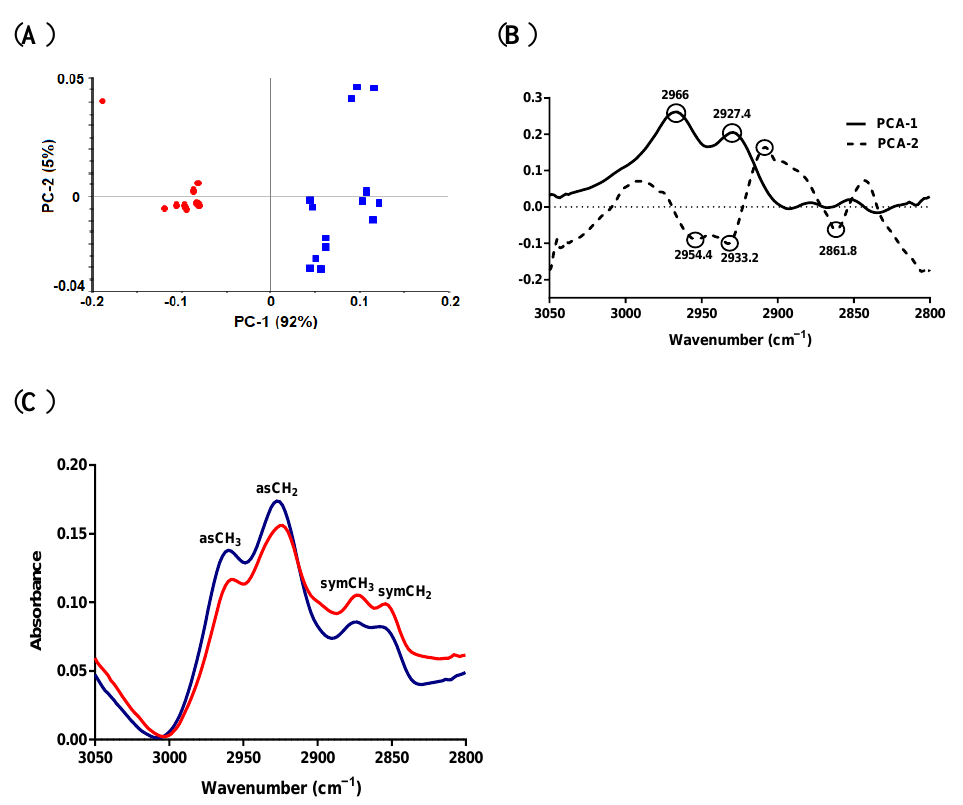
Figure 1. SR-FTIR spectra of lipid region from S. aureus ATCC 29213 (blue) and S. epidermidis ATCC 12228 (red). ( A ) PCA score plot. ( B ) Loading plots of PC-1 and PC-2 of PCA models of lipid region. ( C ) Unit-vector-normalized average raw spectra of lipid peaks and unsaturated lipid region. Table 1. Position assignments of lipids, amide I and amide II component bands altered in SCVs of S. aureus and S. epidermidis